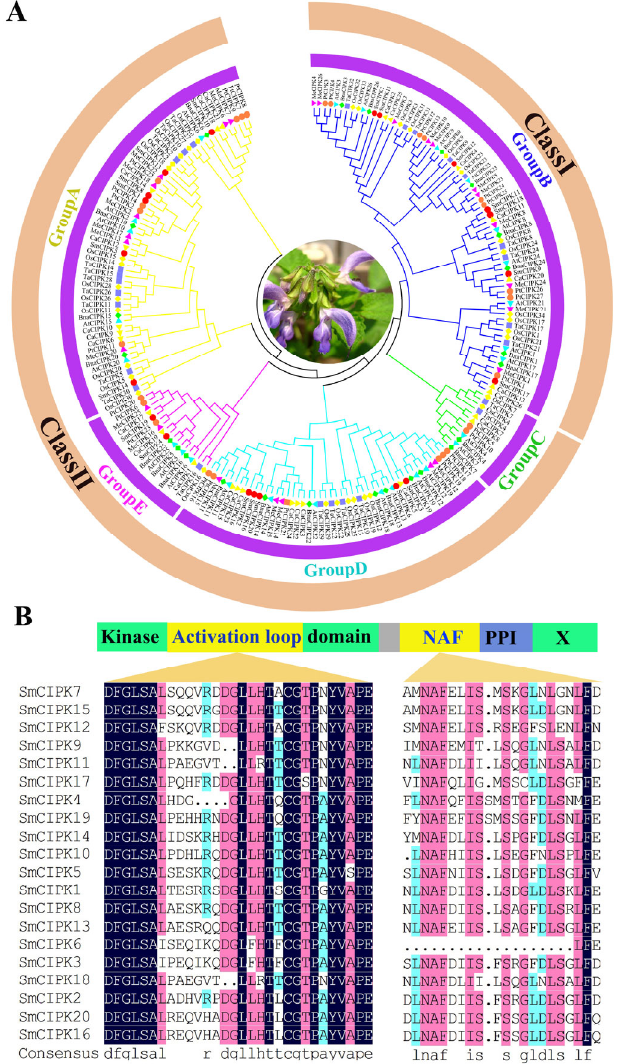
Figure 1. Phylogenetic analysis and sequence alignment analysis of SmCIPKs. ( A ). Phylogenetic trees of SmCIPKs were established with sequences of CIPKs in Capsicum annuum , Arabidopsis thaliana , Manihot esculenta , Populus trichocarpa , Oryza sativa , Triticum aestivum , and Brassica napus species. ( B ). The SmCIPKs protein major activation loop sequences and the corresponding sequences of the proteins within the conserved structural domain of NAF were compared.